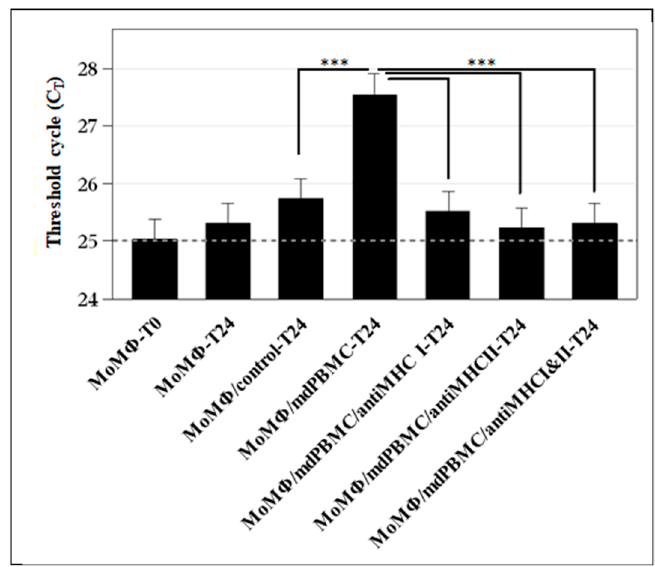
Figure 4. Histogram illustrating simultaneous interaction of antigen-primed antigen presenting cells (APC) with CD4 and CD8 T cells is essential for tri-directional signaling needed to elicit development of CD8 cytotoxic T cells. As illustrated in the figure, maximal killing of intracellular Map was observed with cultures of mdPBMC stimulated with MMP-primed APC in the absence of anti-MHC mAbs (compare center column with negative controls on the left). Development of CD8 CTL was interrupted in cultures of mdPBMC containing mAbs to MHC I and II, and cultures containing mAbs to MHC I or MHC II alone (compare the central column with results with cultures containing mAbs to MHC) on the right of the histogram plots. Data shown are the least squares means and standard deviations for experiments on blood collected from 3 steers. Significance symbols represent P-values adjusted for all pairwise comparisons such that: *** Padj < 0.001. See citations for methods and documentation